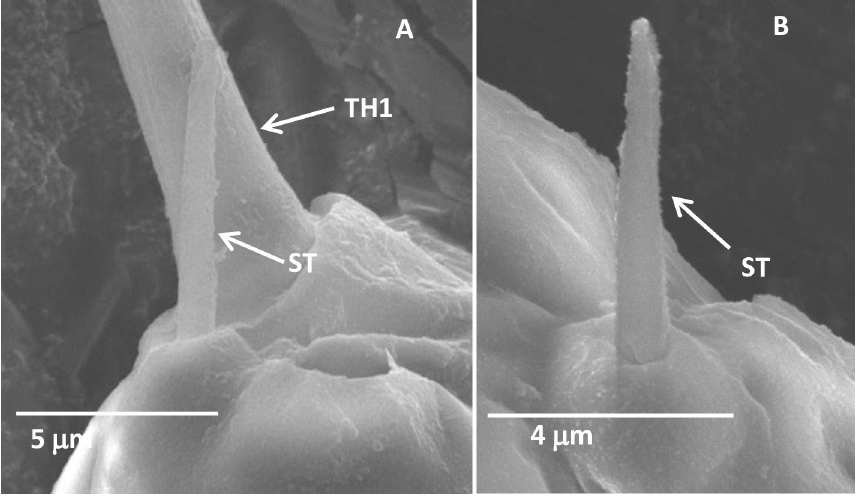
Fig 3. Sensilla trichoidea in the third-instar Diaphorina citri nymphs. (A) The long terminal hair and sensilla trichoidea. (B) Sensilla trichoidea. TH1, the long terminal hair; ST, sensilla trichoidea.